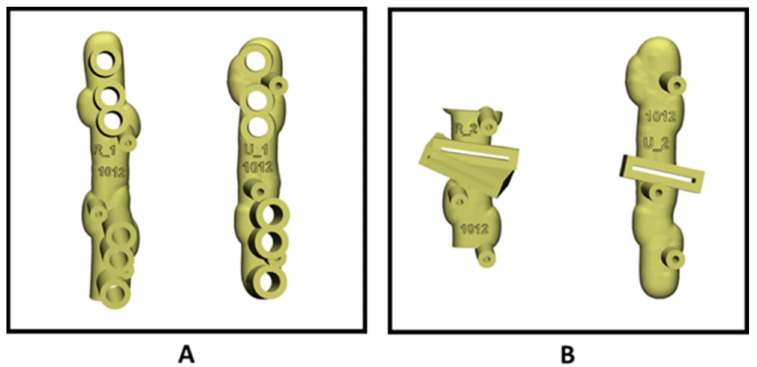
Figure 3. ( A ) Patient-specific drilling guides for the radius (left) and ulna (right), and ( B ) patient- specific saw guides for the radius (left) and ulna